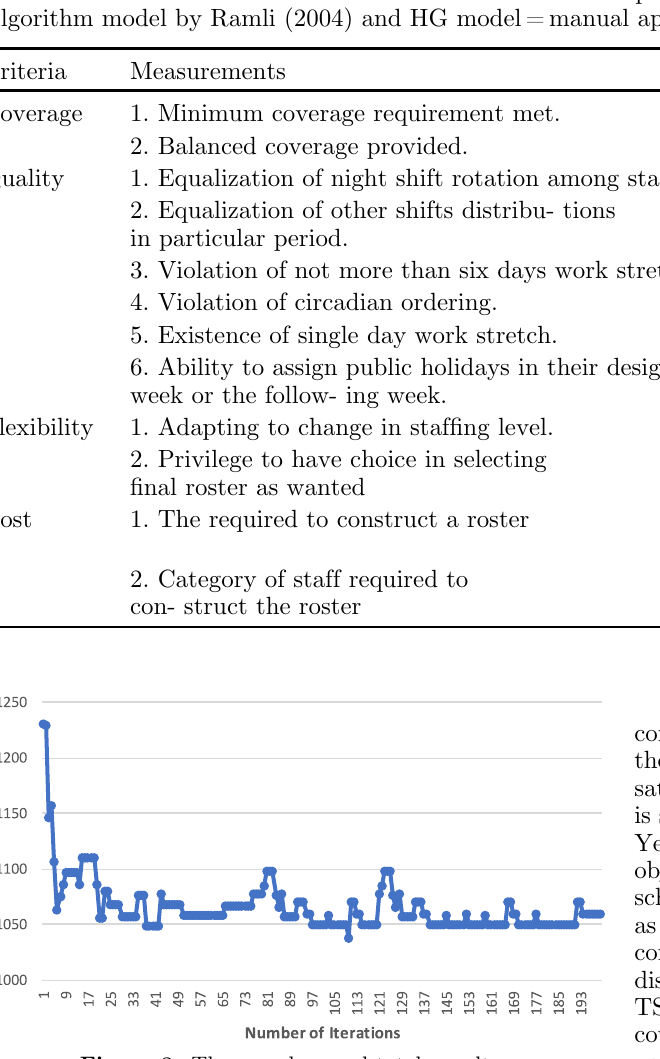
Figure 8. The sample grand total penalty.